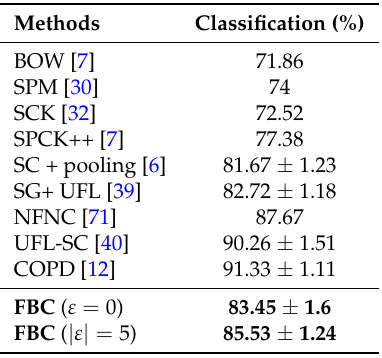
Table 2. Mean classification accuracy comparison on the UCM dataset. SPM, spatial pyramid matching kernel; SCK, spatial co-occurrence kernel; SPCK, spatial pyramid co-occurrence kernel; UFL, unsupervised feature